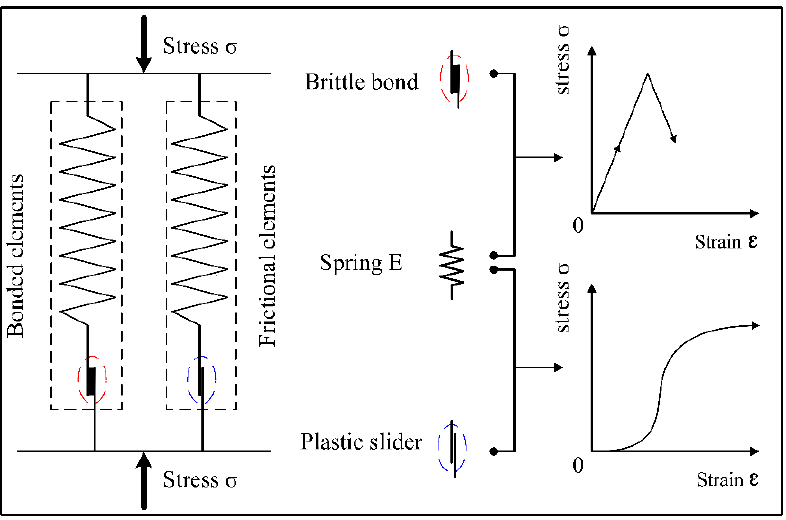
Figure 8. The binary-medium model component diagram.